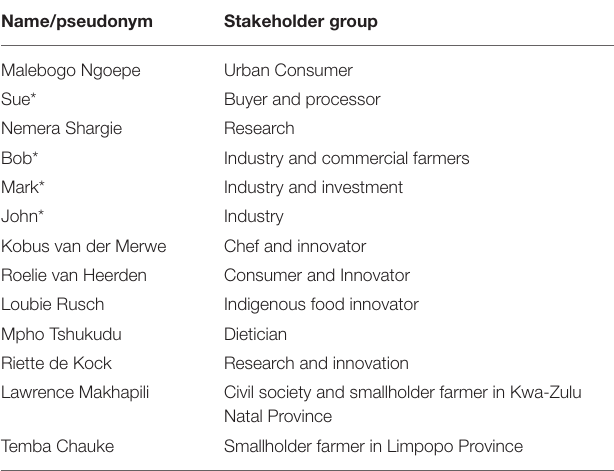
TABLE 1 | List of key informants and the stakeholder group they